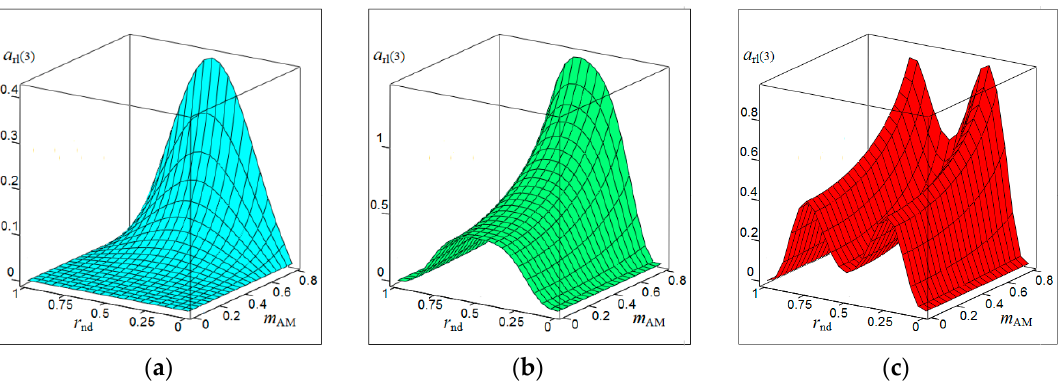
(3) a of the autodyne signal on the variation of the oscillation amplitude with AFM Figure 4. CAS Figure 4. CAS a rl ( 3 ) of the autodyne signal on the variation of the oscillation amplitude with AFM on rl the third harmonic of the modulation frequency calculated for di ff erent values of k FM : ( a ) k FM = 0, on the third harmonic of the modulation frequency calculated for different values of ( b ) k FM = 2, and ( c ) k FM =